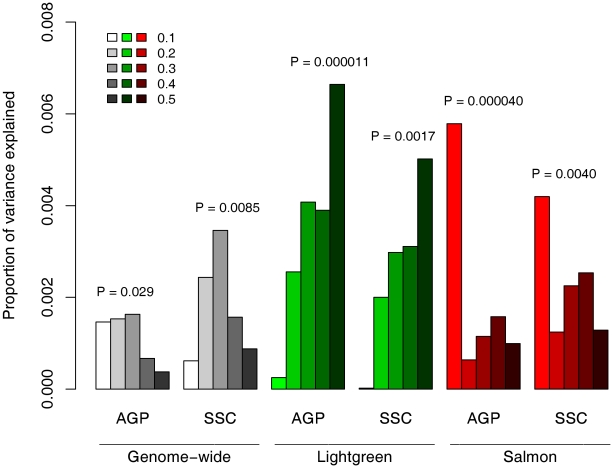
Contribution to ASD risk of common variation in the neuronal sub-networks.Genetic risk scores were calculated for each individual in the AGP and SSC cohorts, based on the genotypes of 79,079 tag SNPs and the association signal in these SNPs in the AGRE cohort. These scores were used to predict ASD status in a logistic regression model. To test the Lightgreen and Salmon modules, the analysis was limited to tag SNPs residing in genes in these modules. In each module and cohort, different series denote different thresholds of P-values, from PT<0.1 to PT<0.5.